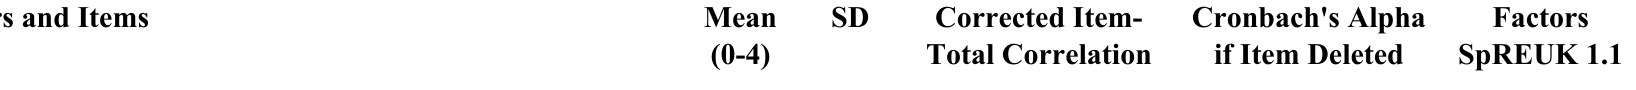
Table 1. Mean values of the items and reliability of the